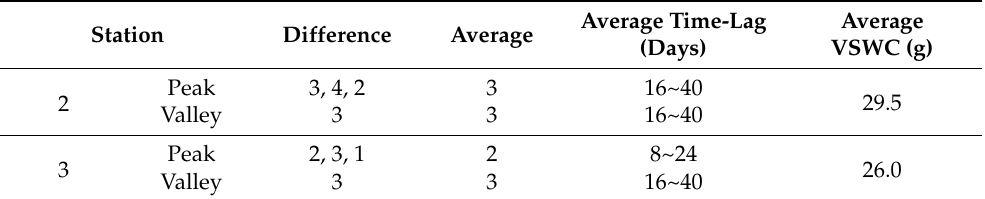
Table 3. Statistics of difference between peak/valley of agriculture.